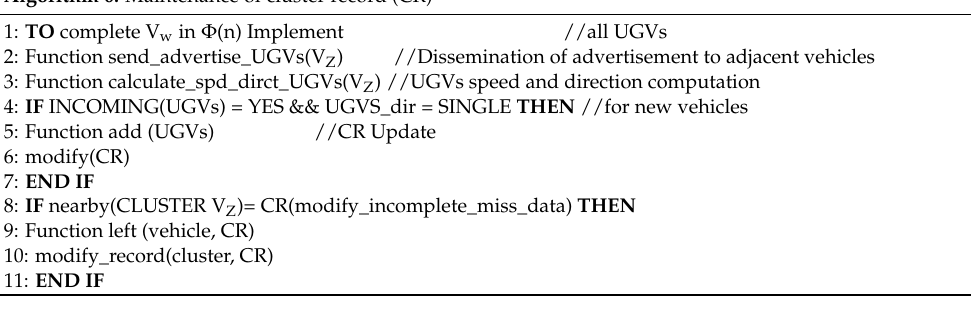
Algorithm 6. Maintenance of cluster record (CR)